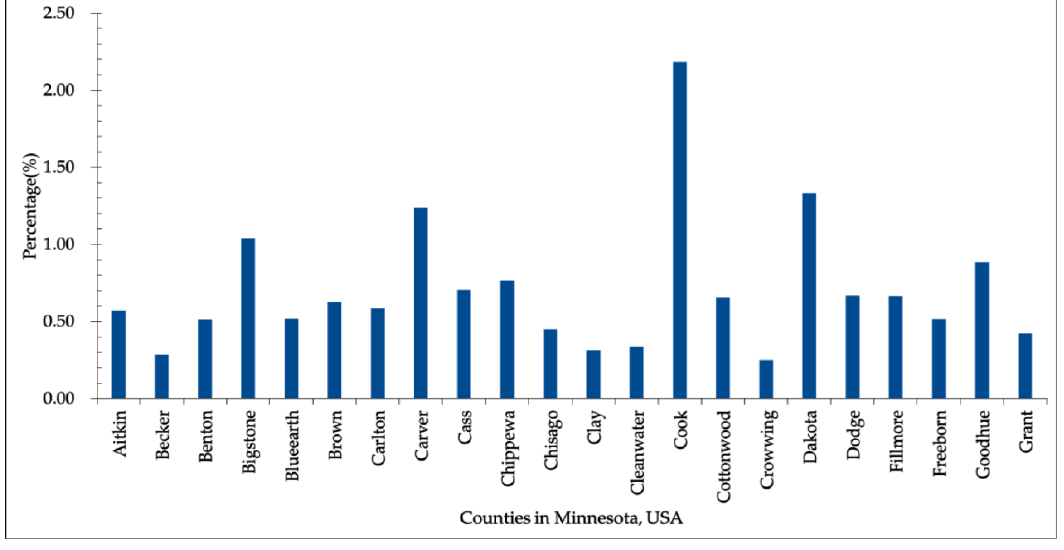
Figure 5. The percentage of the maximum total number of cells in P and Q in all cells (excluding NODATA cells) for the 3-m LiDAR-based DEM of twenty-two counties in Minnesota, USA.